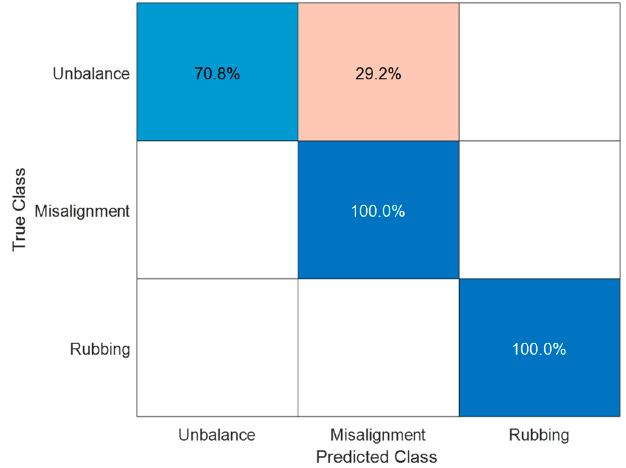
Figure 8. Test confusion matrix showing the performance of the pretrained deep learning model on unseen simulation test data (90.27% accuracy on test data).